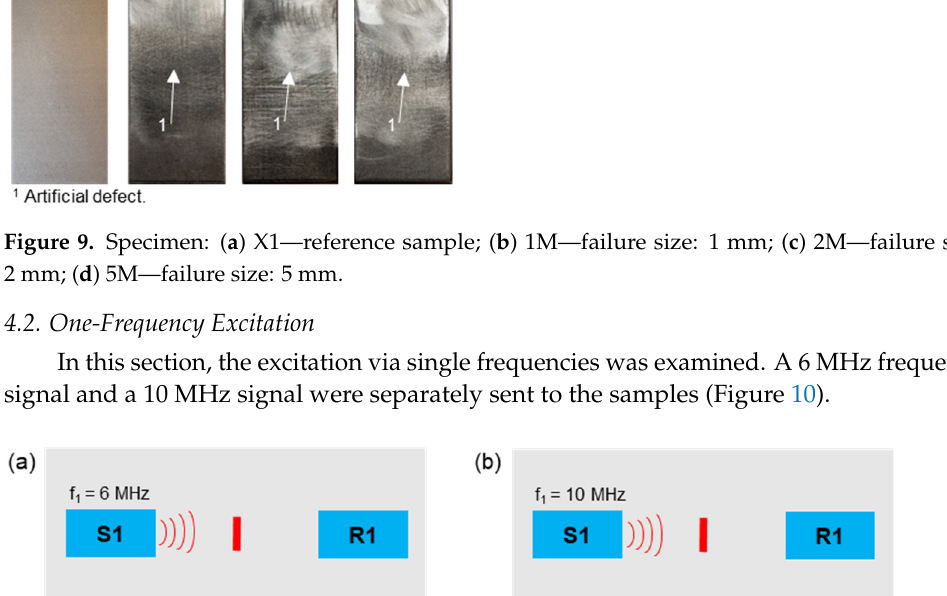
Figure 11. Nonlinearity parameter: ( a ) f 1 = 6 MHz; ( b ) f 1 = 10 MHz. 4.3. Two-Frequency Excitation 4.3.1. Constant Frequencies If two frequencies emitted in parallel are used, the evaluation becomes more complex since a total of 12 harmonic and sideband frequencies are formed which can be evaluated. This technique was successfully used and proven in [17]. A 6 MHz and 10 MHz signal were generated, superimposed, and sent via sensor S1 (Figure 12). If the waves overlap, harmonic frequencies and more complex modulated response frequencies were gener- ated, which are evaluated in the following. To compensate the overlapping effects of al- ternating compressive and tensile stresses on the various sine waves, 100 signals were transmitted per experiment and the mean values of the amplitudes were evaluated. Figure 12. Excitation frequencies: f 1 = 6 MHz, f 2 = 10 MHz. Figure 13 reveals the evaluation of the nonlinearity parameters, and all demonstrate a change compared to the reference sample. The parameter value δ 2f 2 showed a clear pat- tern depending on the crack size. This phenomenon was moreover observed in [17,36], where the largest nonlinearities were not generated for the largest crack. These are